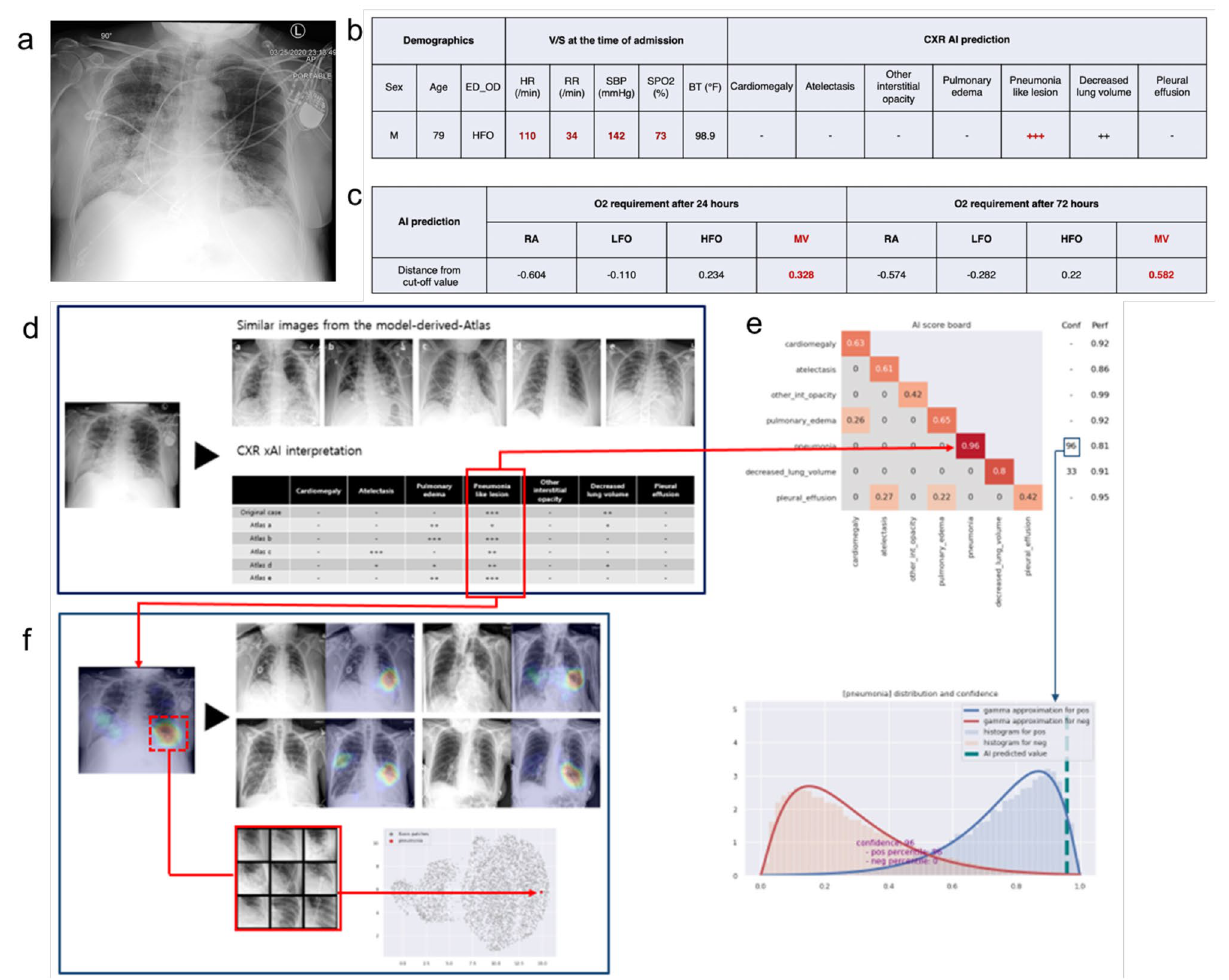
Figure 8. AP CXR of a 79-year-old man with COVID-19 and respiratory insufficiency and AI prediction of most likely stage of oxygen requirement at 24 and 72 h from the time of ED admission. ( a ) AP CXR obtained on ED admission, ( b ) Clinical information and infection-associated radiographic labels identified by our CXR xAI model, ( c ) Final prediction of oxygen requirement after 24 and 72 h. Our COVID-19 xAI model predicted that the patient would require MV after 24 and 72 h, ( d ) Prediction probabilities for 7 infection-associated radiographic labels are summarized in the interpretation table and 4 similar CXRs with characteristic findings for pneumonia were selected from the Model-Derived Atlas, ( e ) Pneumonia was identified as a significant feature, based on high prediction probability and calibrated classifier confidence on the AI scoreboard, ( f ) Pneumonia was correctly localized by Grad-CAM, and on UMAP, the test patch was closely located to corresponding patches from the Model-Derived Atlas in the embedding space after dimensionality